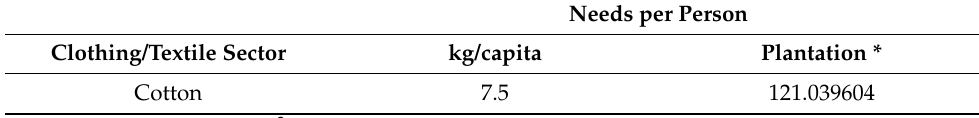
Table 5. Ecological footprint or land demand per person of clothing/textile sector in Java Island.